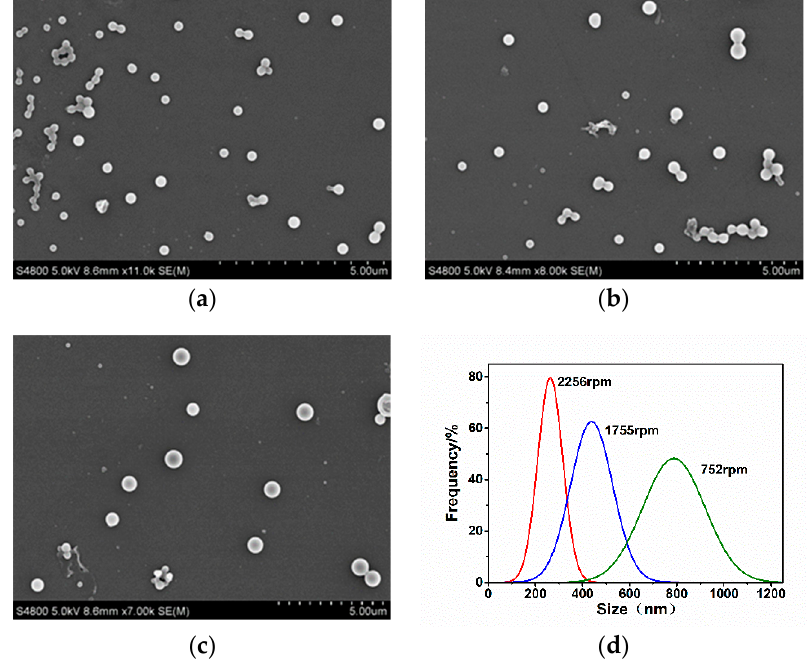
Figure 5. SEM images of SRL nanoparticles prepared under different rotating speeds: ( a ) 37 g; ( b ) 22 g; ( c ) 4 g; ( d ) the corresponding PSDs.